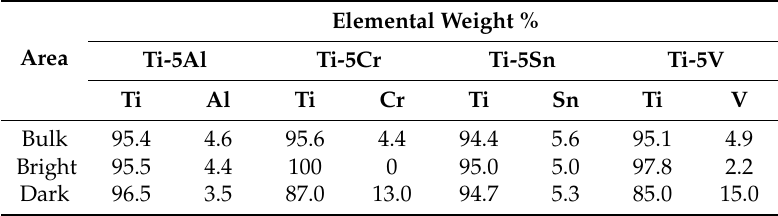
Table 2 lists the Vickers microhardness value of cp-Ti and Ti alloys. Vickers microhardness values of Ti alloys were increased compared to those of cp-Ti by the solid solution strengthening effect.